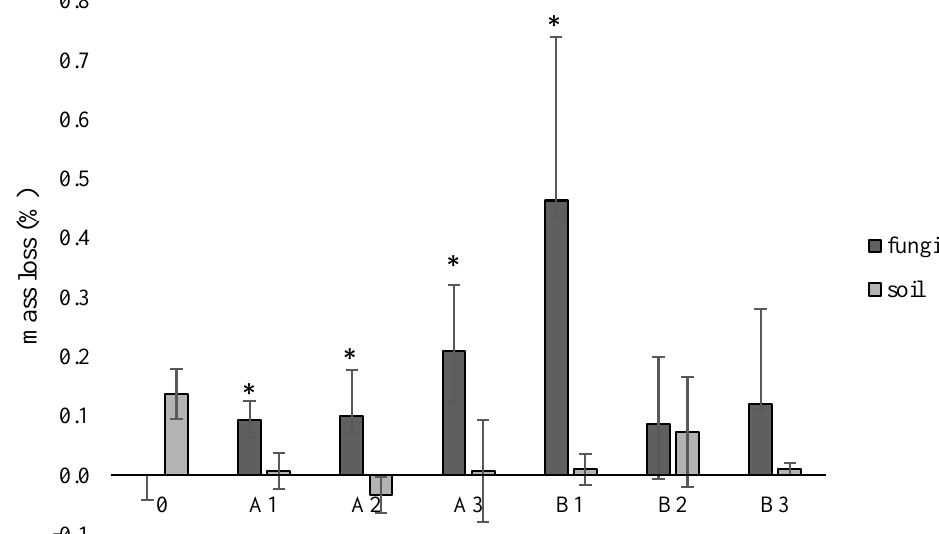
Figure 6. Mass loss (%) of the samples after incubation with fungi or in the soil solution, compared to the control samples. * — statistically significant difference based on the one-way ANOVA analysis. Abbreviations: as in Table